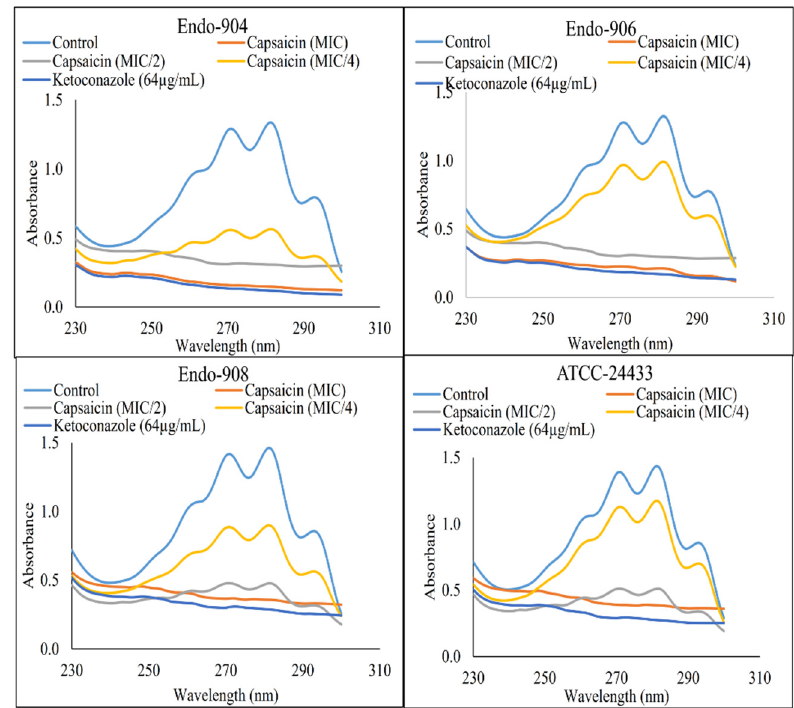
Figure 3. Spectrophotometric sterol profiles of C. albicans (Endo-904, Endo-906, and Endo-908). Sterols were extracted from the cells and spectral profiles between 230 and 300 nm were determined.